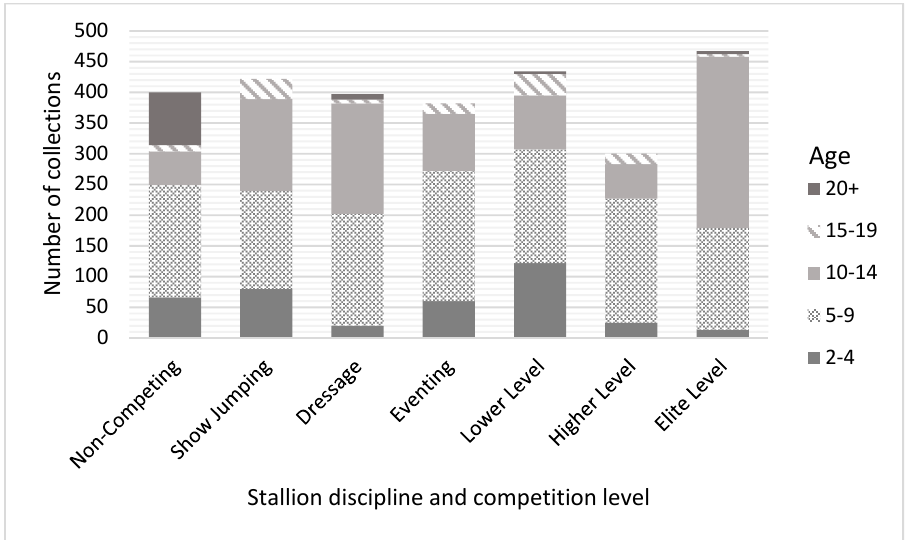
Figure 1. Number of semen collections from each age category within stallion discipline and competition level.